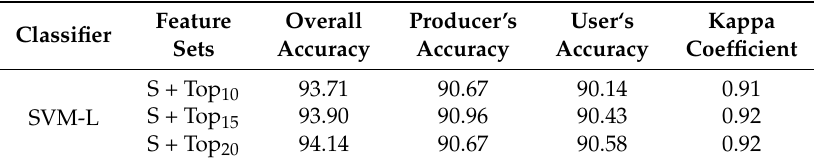
Table 4. The accuracy of SVM-L using different number of